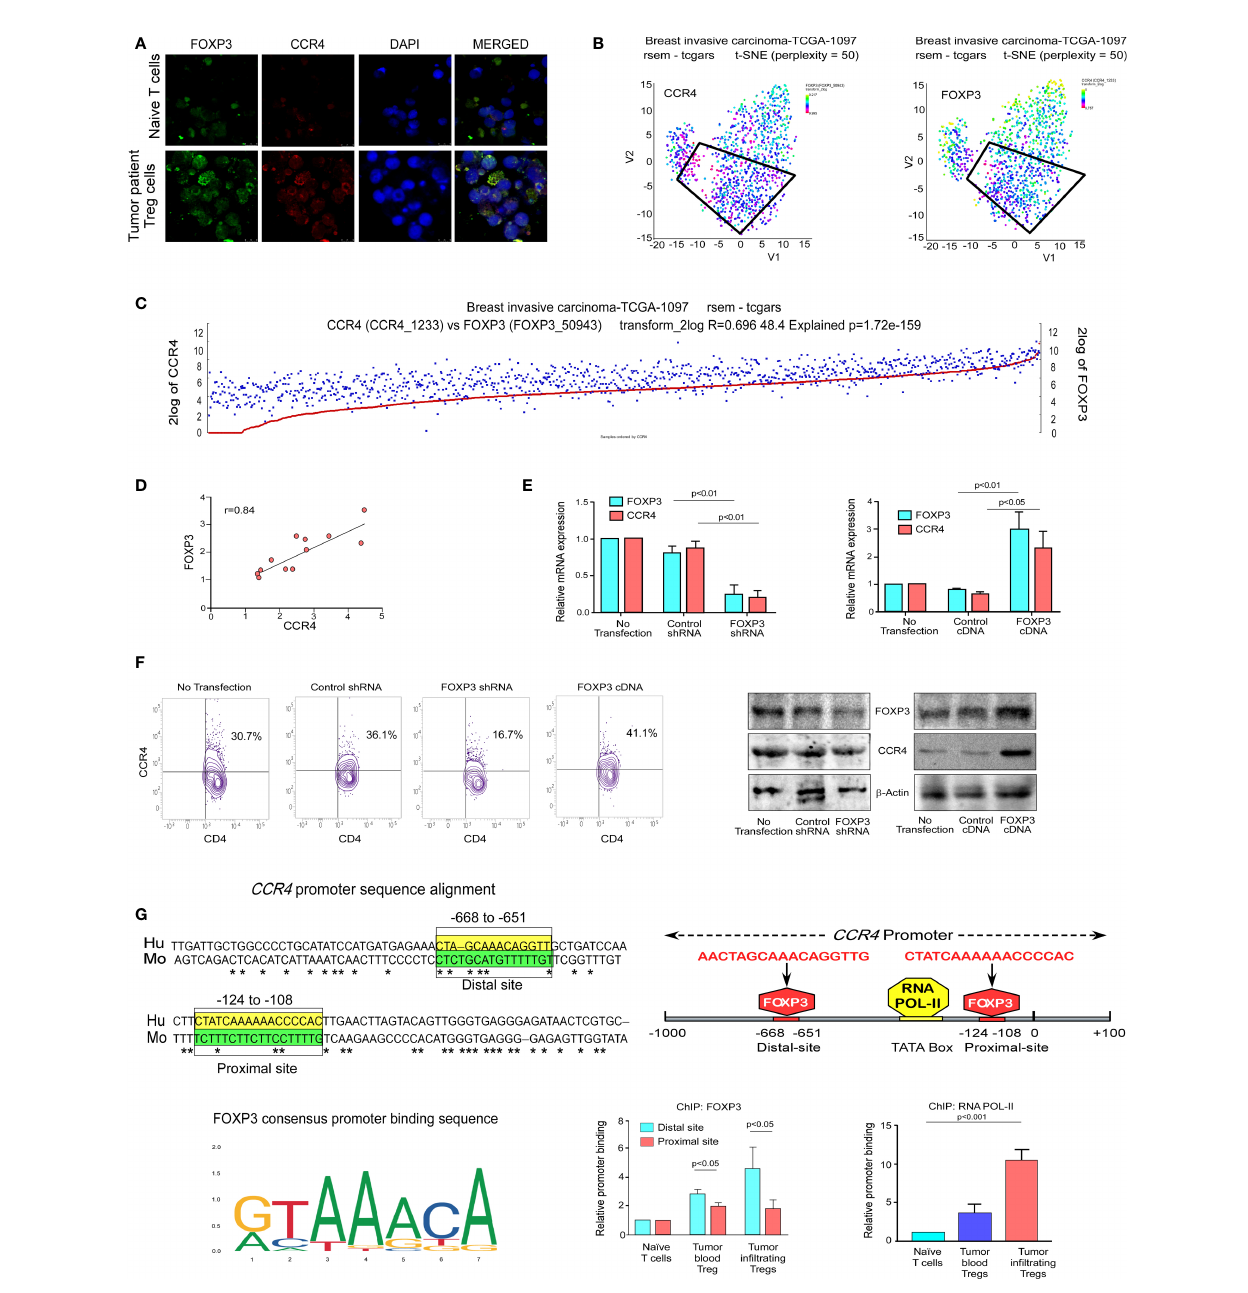
FIGURE 3 | FOXP3 binds at the CCR4 promoter and regulates CCR4 expression in Treg cells. (A) The confocal microscopy data showing the expression of CCR4 and FOXP3 in naïve T cells and Treg cells of breast cancer patients. (B) the t-SNE plot of TCGA data from invasive breast carcinoma patients ( n = 1,097), revealing CCR4 and FOXP3 expression levels. (C) FOXP3 and CCR4 correlation plot were derived from TCGA data of invasive breast cancer patients ( n = 1,097). (D) Representative correlation coef fi cient plots depicting the relationship between CCR4 and FOXP3 in core breast tumor tissue taken from breast cancer patients at various stages ( n = 12). (E) CCR4 and FOXP3 relative mRNA expression in FOXP3-ablated (left panel) and FOXP3-overexpressed (right panel) Tregs induced by shRNA or cDNA. (F) CCR4 protein expression in FOXP3-de fi cient and FOXP3-overexpressed Tregs ( fl ow cytometry; left panel, Western blot; right panel). (G) The Fork-head DNA-binding site has been identi fi ed in a Clustal W depiction of multiple sequence alignment of the CCR4 promoter between human and mouse (upper left panel). The consensus DNA-binding sequence for fork-heads has been discovered (obtained from Jasper) (lower left panel). On the CCR4 promoter, there are two FOXP3-binding sites (Distal site: − 668 bp to − 651 bp and Proximal site: − 124 bp to − 108 bp) as well as an RNA POL-II binding region (TATA-Box) (upper right panel). The relative binding of FOXP3 at the CCR4 promoter ’ s distal ( − 668 bp to − 651 bp) and proximal ( − 124 bp to − 108 bp) sites are depicted graphically (lower middle panel). The relative binding of RNA POL-II to the TATA-box of the CCR4 promoter has been graphically depicted (bottom right panel). GAPDH and b -actin were used as internal controls. The values are the mean ± SD of three sets of independent